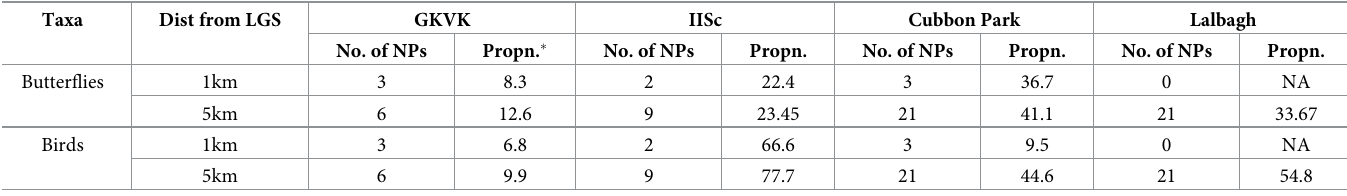
Table 3. Contribution of NPs to the faunal diversity within